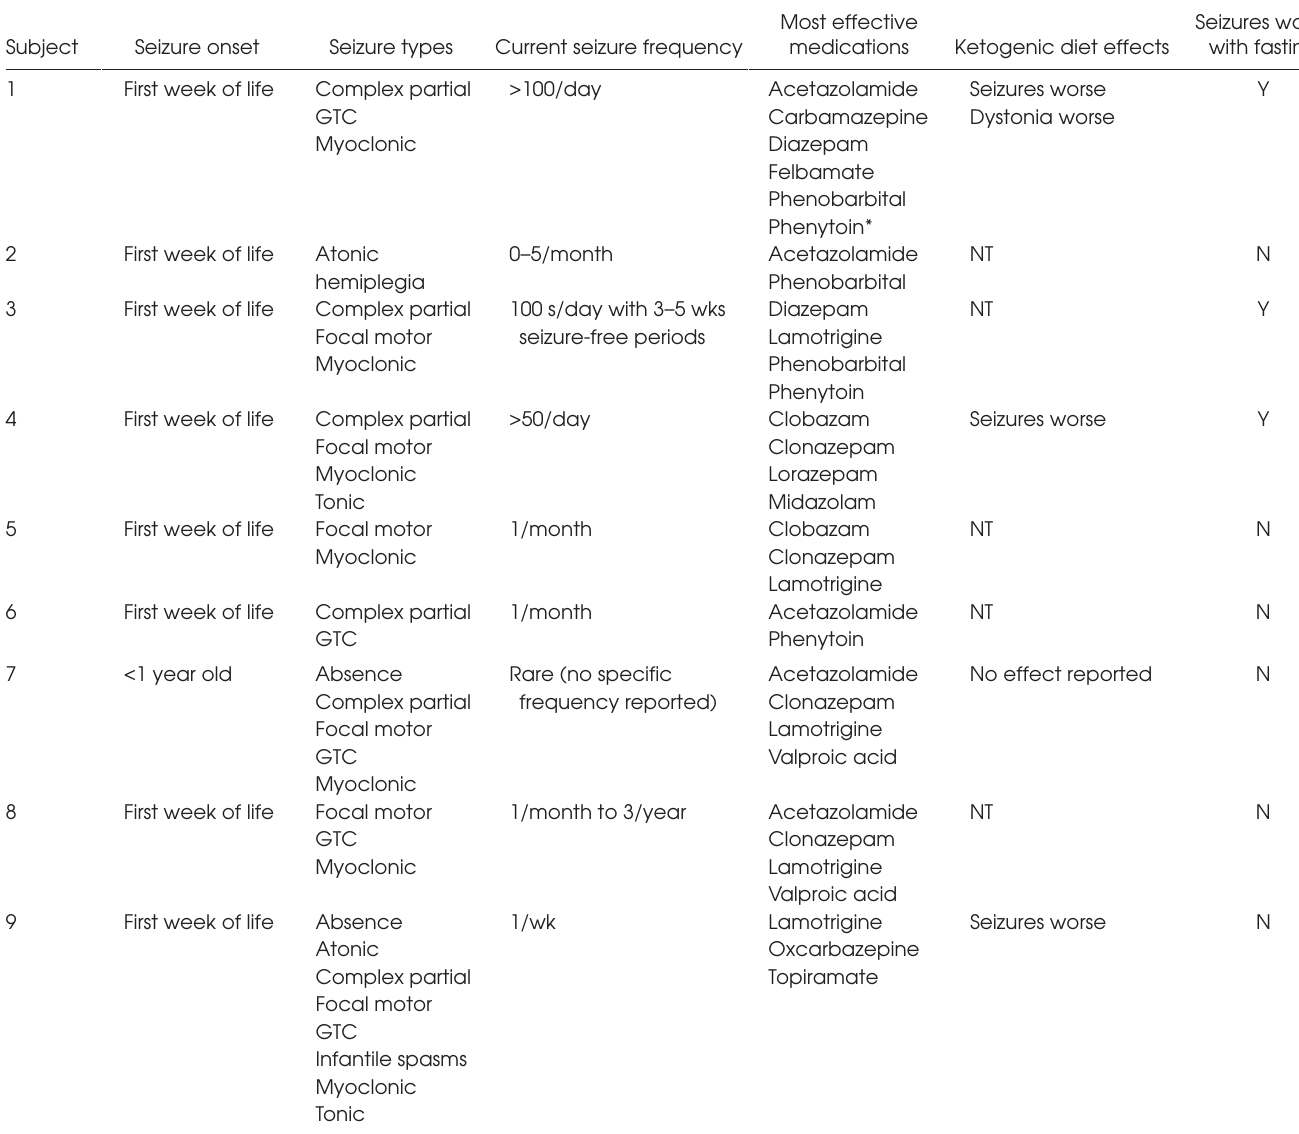
table 3. Information on seizures in children with SLC13A5 mutations in this study.